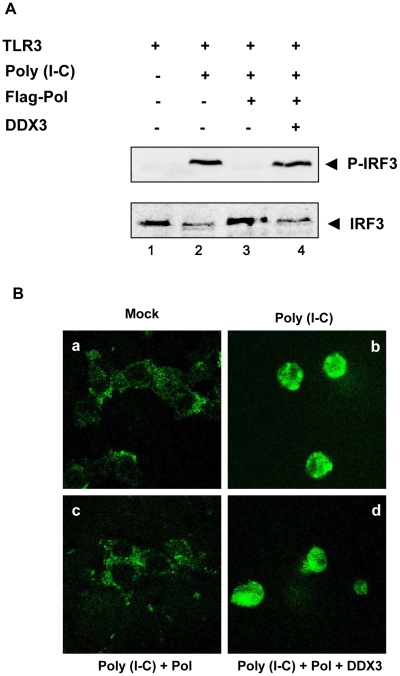
HBV Pol inhibits both phosphorylation and nuclear translocation of IRF3.(A) HEK293 cells were transfected with TLR3, HBV Pol, and DDX3 expression construct as indicated. Two days posttransfection, cells were stimulated with poly I∶C for 8 h. Western blot analysis was performed as described in Materials and Methods. (B) HEK293 cells were transfected with GFP-IRF3, TLR3, HBV Pol, and DDX3 expression constructs, as labeled either above or below each panel by a, b, c, and d. Two days posttransfection, cells were treated with poly I∶C for 8 h. Cells were examined by confocal microscopy.